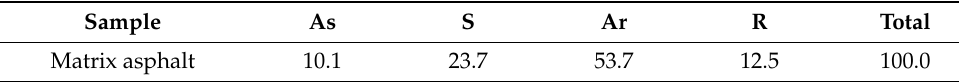
Table 2. Asphalt four-component content(%).